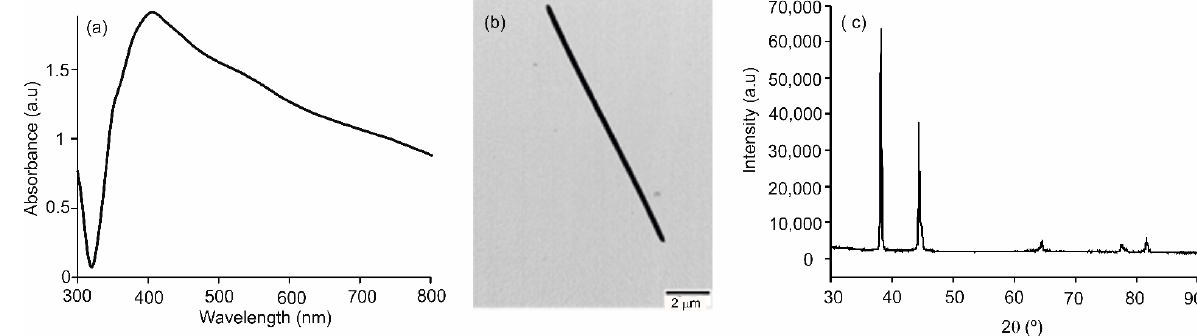
Figure 1. ( a ) UV–Vis absorption spectrum of the ethanol suspension; ( b ) TEM image and ( c ) XRD pattern of the purified silver nanowires (AgNWs).